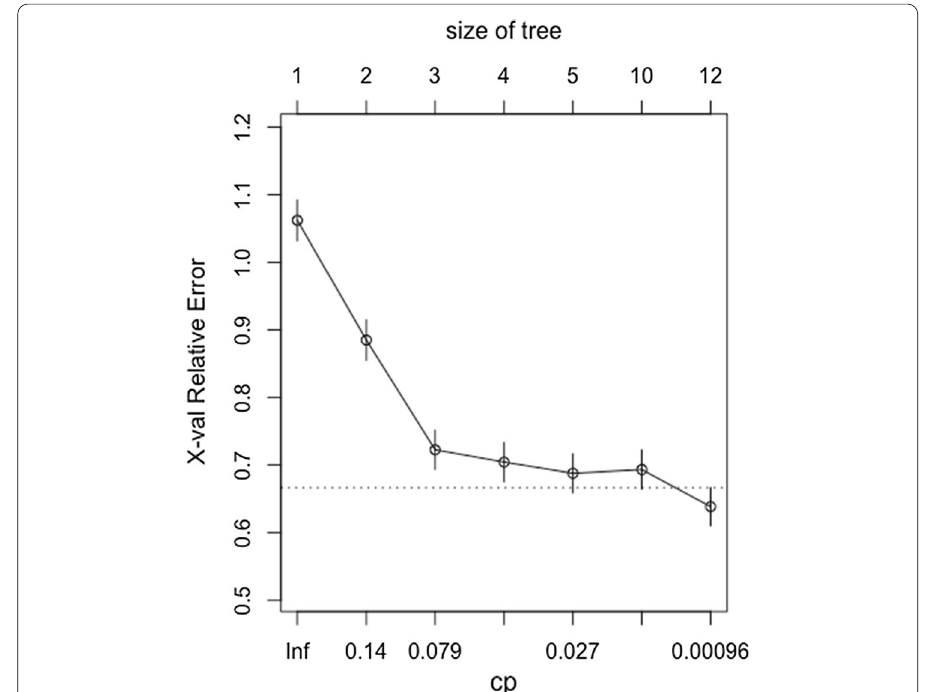
Fig. 2 Complexity Parameters for Attributes Prediction. The optimum number of branches can be determined by the minimum error and the optimum